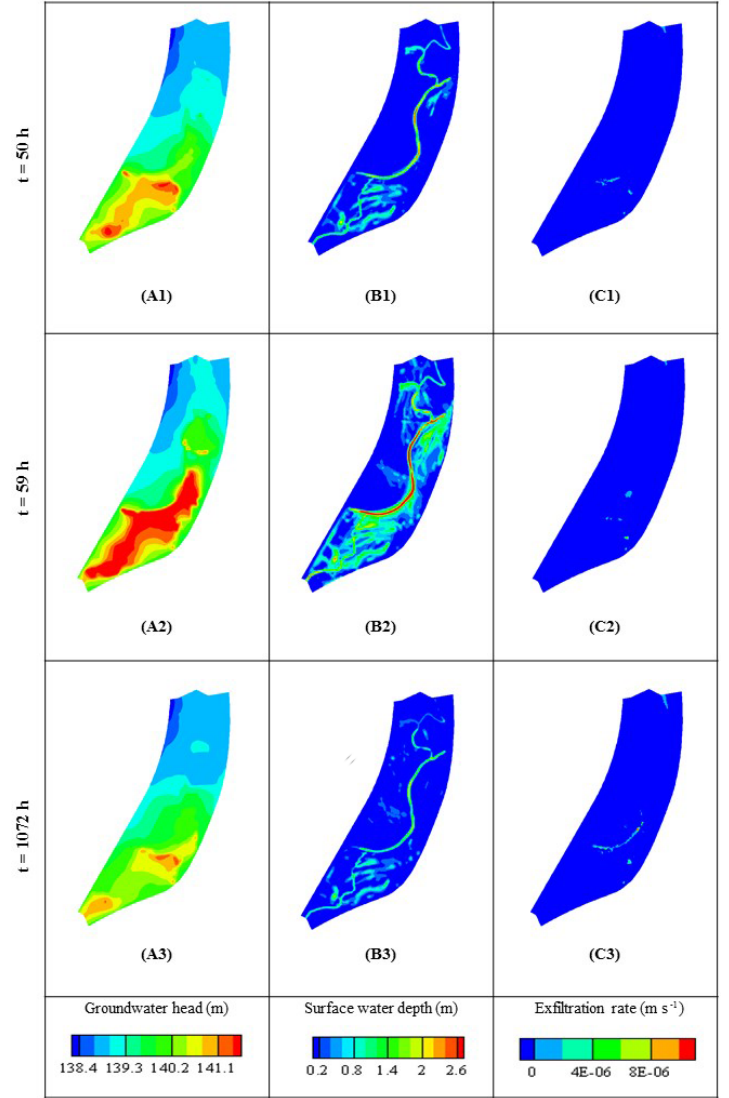
Figure 8. Groundwater head, surface water thickness, and exfiltration rate over the whole of Rohrschollen Island for three different periods (in hours after the beginning of injection) of the calibration period. Notably, the last period is also the date of the airborne thermal infrared